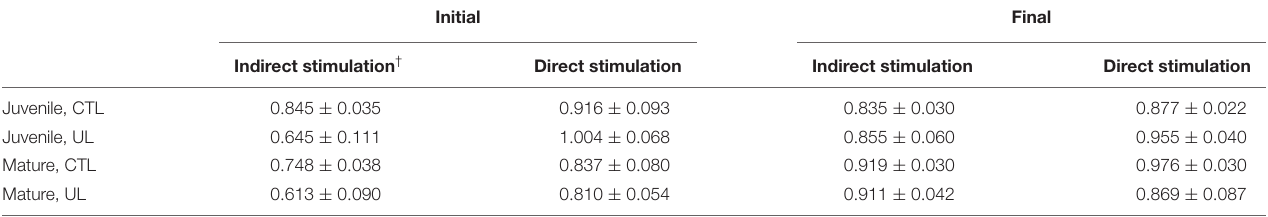
TABLE 4 | Effects of age (mature/juvenile) and treatment (control/unloaded) on time to peak tension (seconds) at beginning (Initial) and conclusion (Final) of 5 min train of indirect (nerve) or direct (muscle) stimulation.